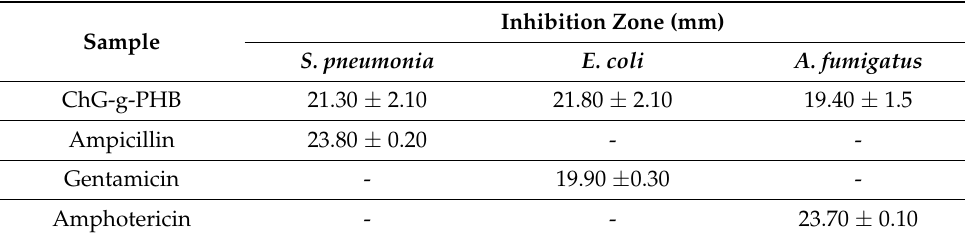
Table 2. Antimicrobial activity of ChG-g-PHB Adapted from [139].